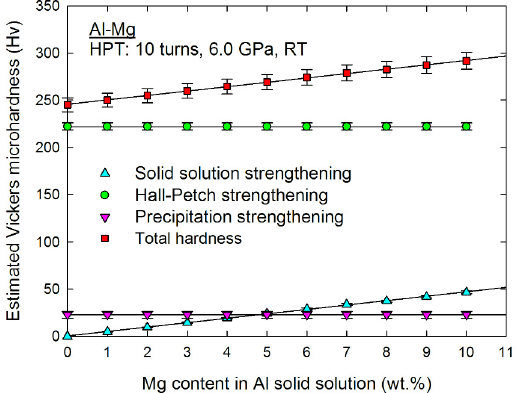
Figure 4. Estimated Vickers microhardness values with increasing Mg content in Al solid solutions in the disk after HPT for 10 turns.